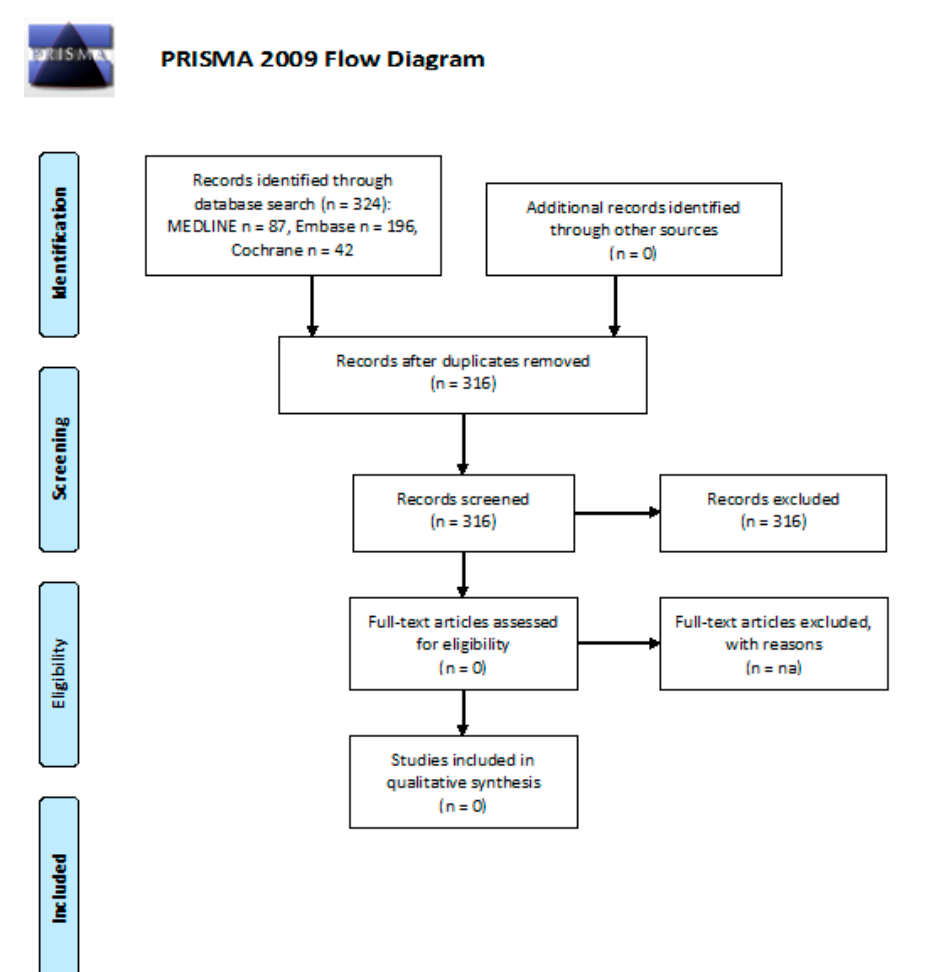
Figure 2. PRISMA flow diagram on the efficacy of follow-up programs for the diagnosis and management of peripheral neuropathy.